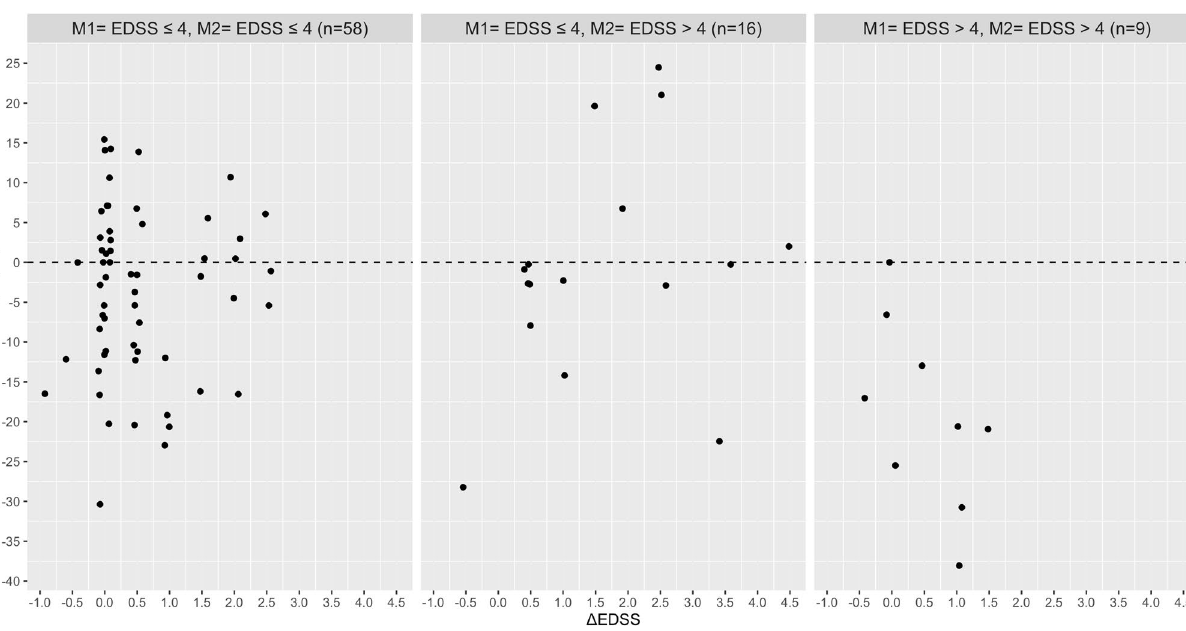
Figure 2. Relationship between the absolute change in stride length with absolute change in the EDSS score according to disability